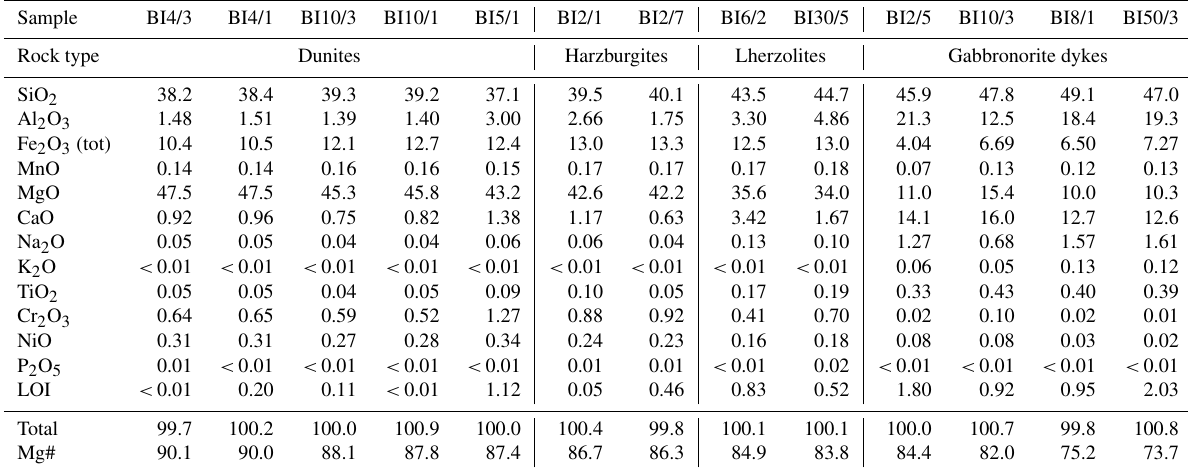
Figure 2. (a) Geological map of the Rocca d’Argimonia area, compiled after Lensch (1968) and Quick et al. (2003), and new field investi- gations. The empty dots represent the sampling sites. A: peridotites BI10/1 and BI10/3, and gabbronorite BI10/3; B: peridotites BI4/1 and BI4/3; C: peridotite BI5/1; D: peridotites BI2/1, BI2/5, BI2/7, BI6/2 and BI30/5, and gabbronorites BI2/5 and BI8/1; E: gabbronorite BI50/3. Location of Bielmonte village is also reported. (b) Synthetic block diagram illustrating the relationships between the different rock types of the Rocca d’Argimonia sequence; the dotted lines within the peridotites represent domains rich in poikilitic orthopyroxene. Table 1. Whole-rock chemical compositions of selected